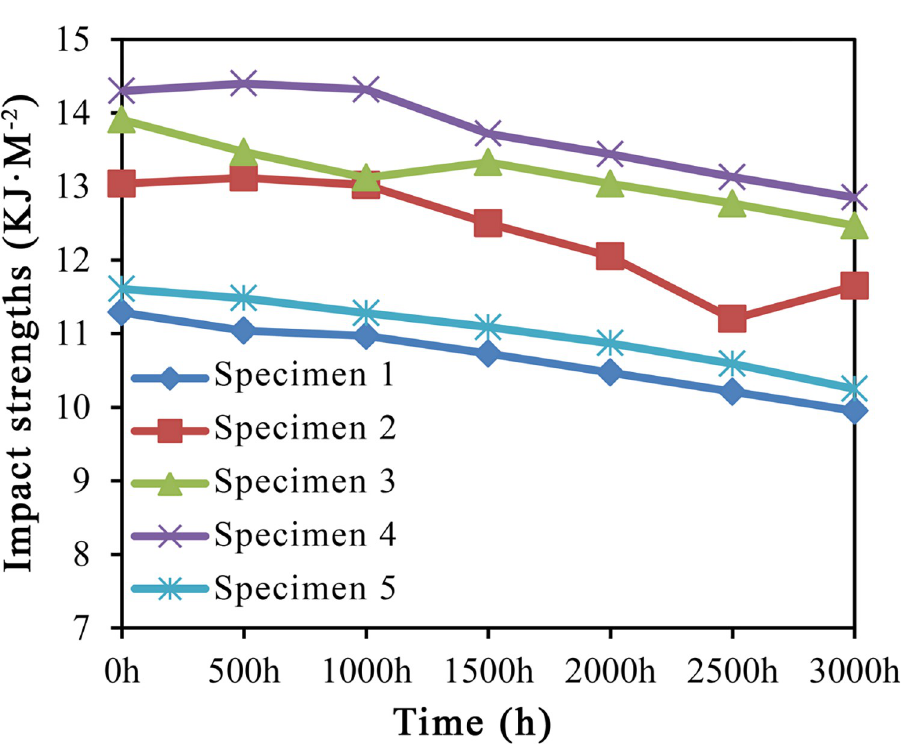
Fig 5. Variation trends of impact strengths.